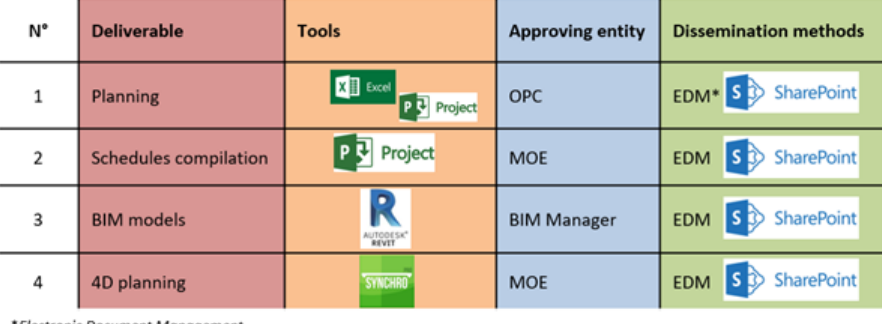
Figure 7. Tools and methods for producing 4D BIM deliverables.